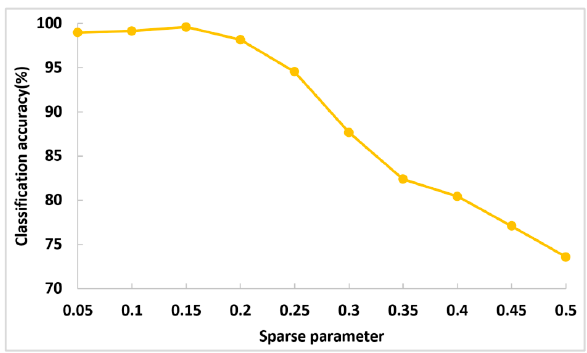
ff erent sparsity